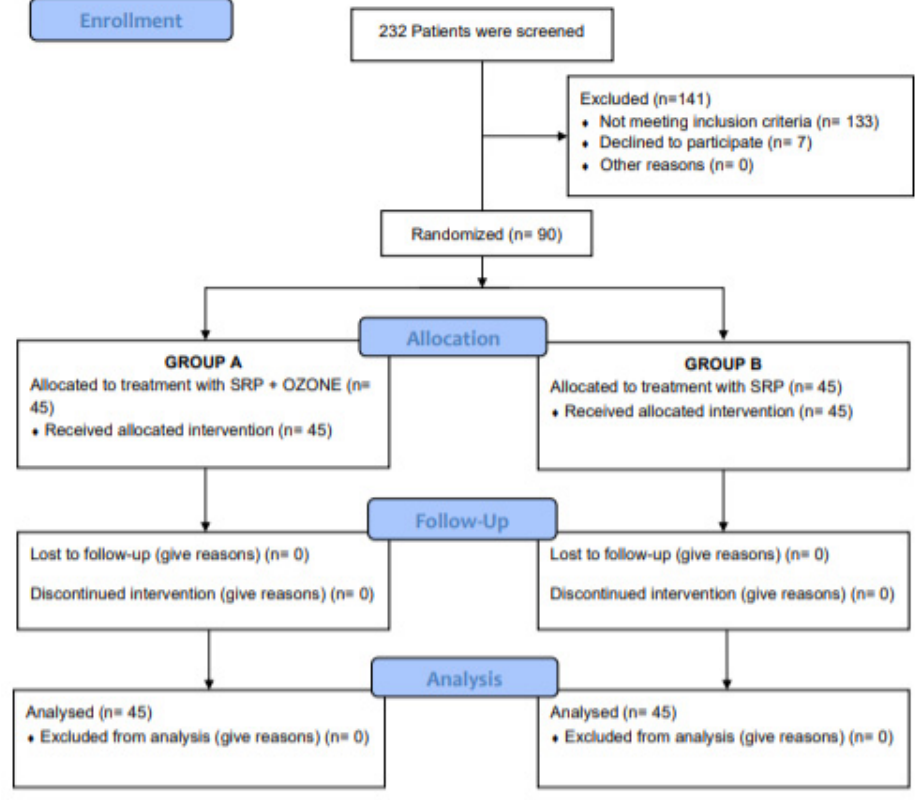
Figure 1. Consort diagram showing the screening, enrolment and randomization of study patients. A total of 90 patients were included in the study. Baseline demographic characteris- tics and clinical periodontal parameters of the 90 patients included in our analysis are illustrated in Table 1 and Table 2, respectively. Table 1. Baseline demographic characteristics of participants.